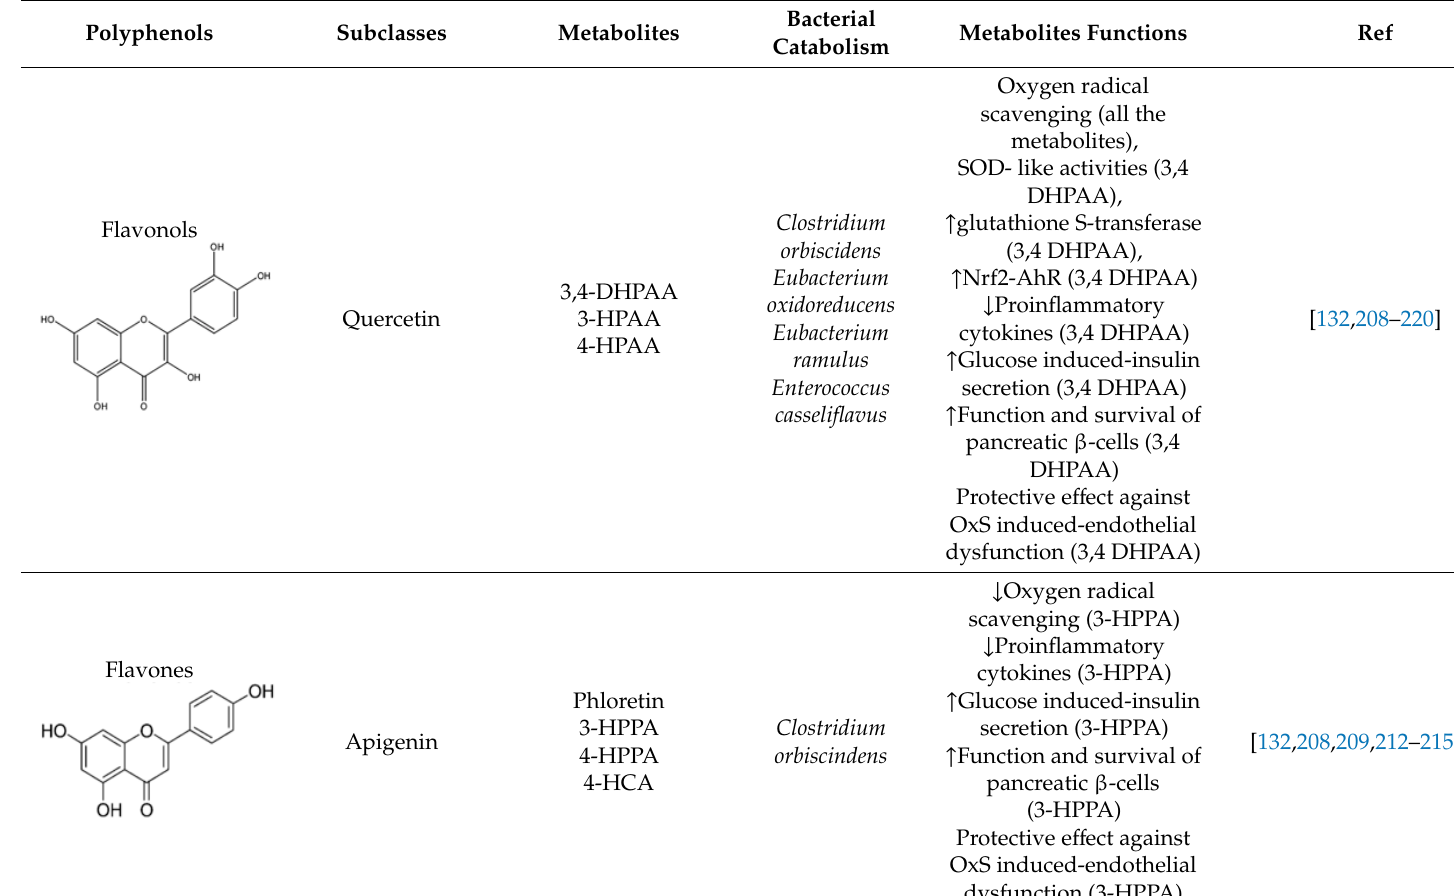
Table 5. Polyphenol metabolites and functions.